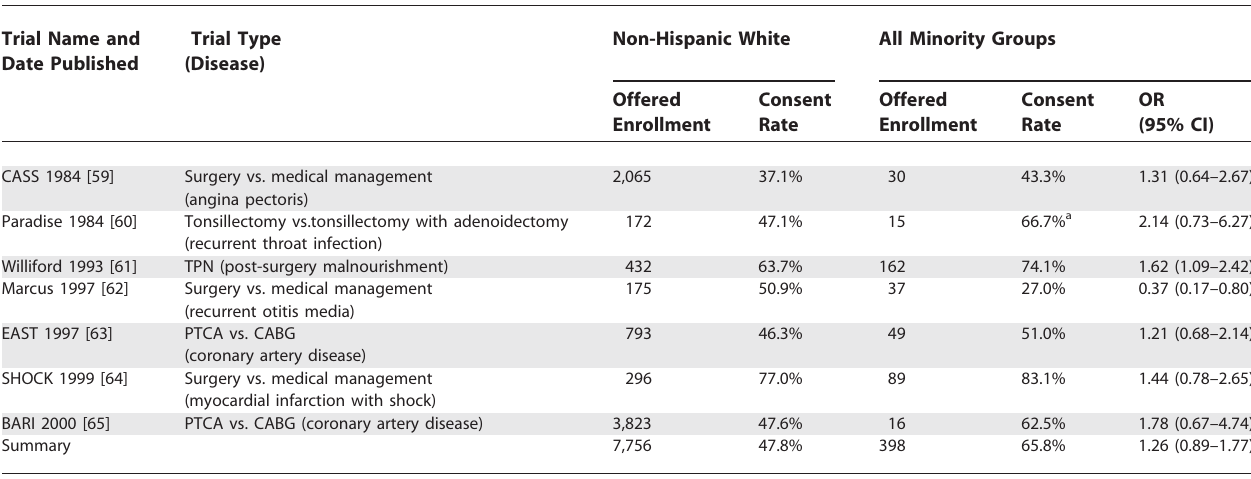
Table 3. Surgical Intervention